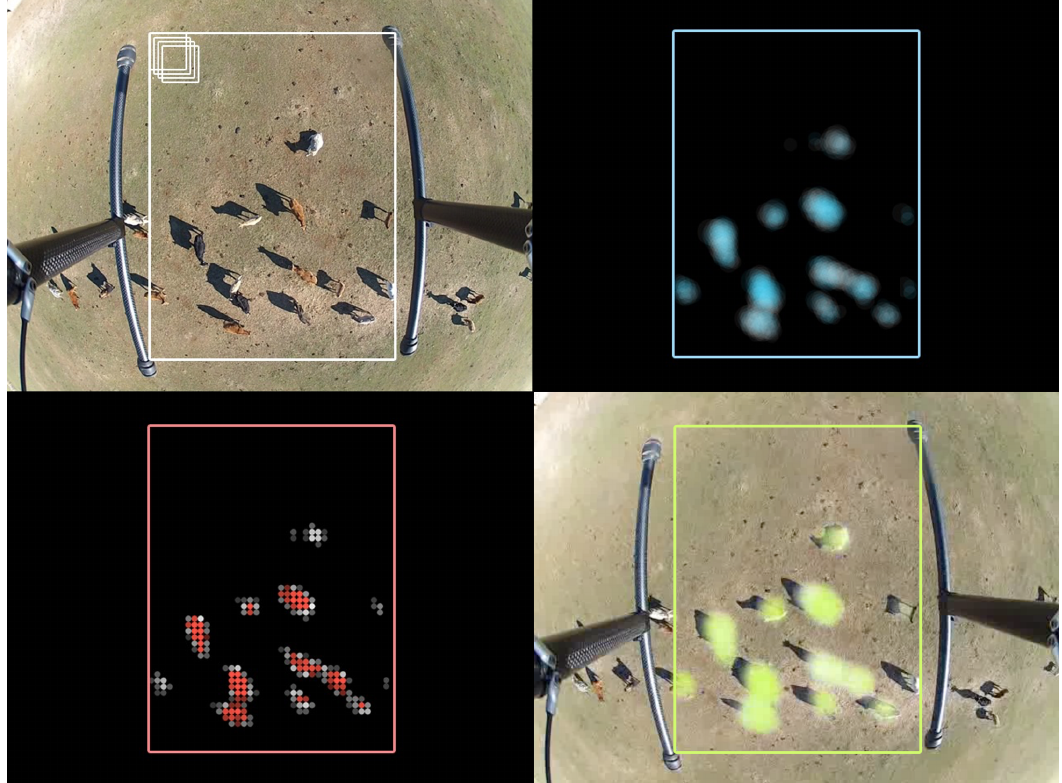
Figure 6. A sample of the data used to train the CNN. Two classes are used: target ( a ); and background ( b ).